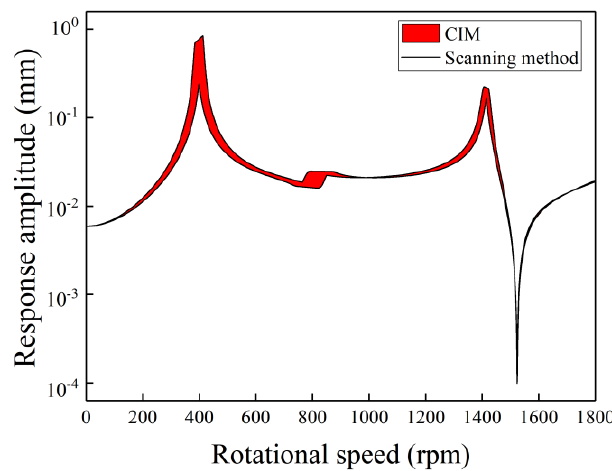
Figure 4. The bounds of uncertain gravity response versus rotational speed by the scanning method and Chebyshev interval method (CIM) with a 10% deviation in the bearing’s stiffness.